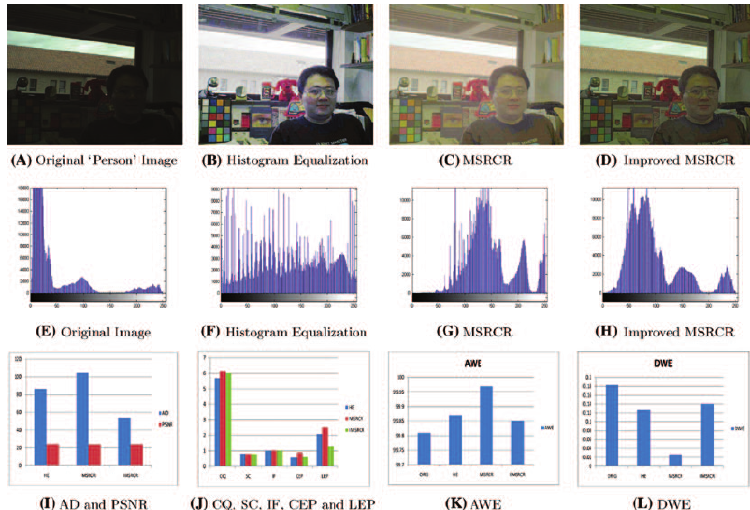
Figure 7. (Top) Image Enhancement Methods. (Middle) Histogram Plots: x -axis, Intensity Levels Ranging from 0 to 255; y -axis, Total Number of Pixels. (Bottom) Conventional Metrics and Proposed AWE and DWE Metrics. The “Person” Image has been Downloaded from http://ivrg.epfl.ch/page-74617-en.html.